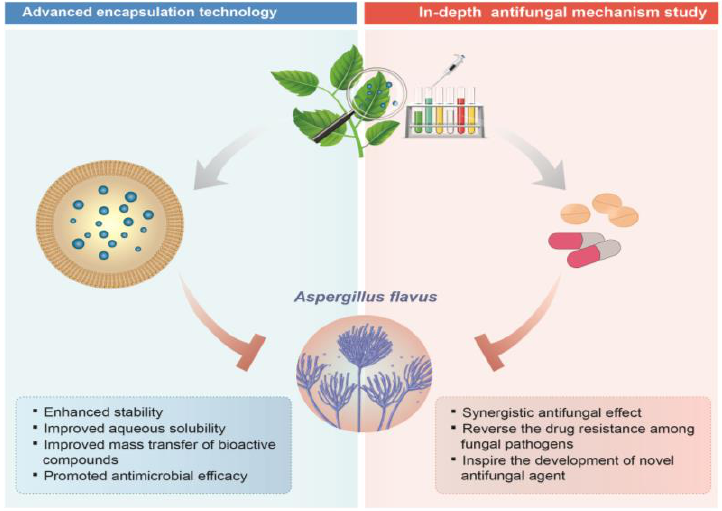
Figure 6. Future perspectives towards the application of plant-derived natural compounds against A. flavus.